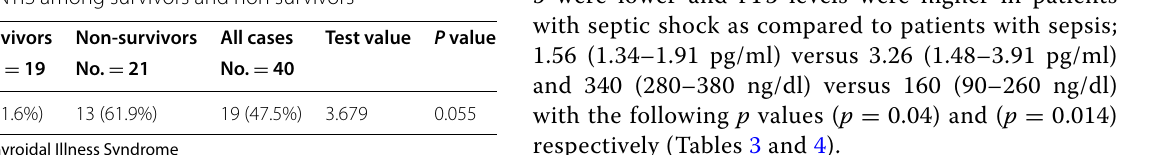
Table 6 Comparison between survivors and non-survivors regarding the thyroid hormone levels in day 1 and day 5